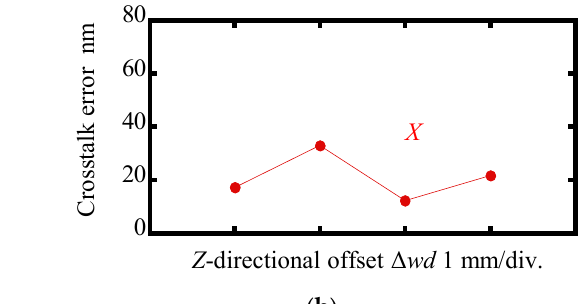
Figure 11. Variations in amplitudes of the interpolation errors as the change in the Z -directional offset Δ wd : ( a ) Measurement of Δ x ; ( b ) Measurement of Δ z .